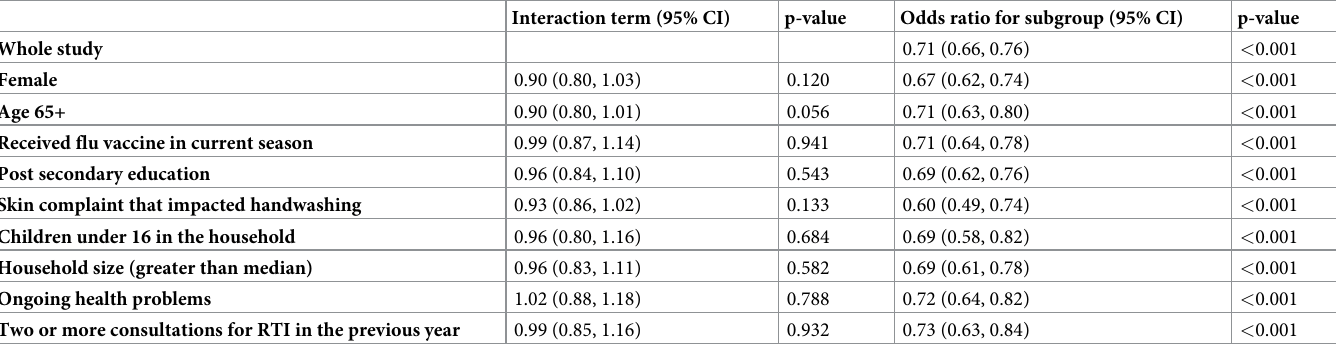
Table 3. Subgroup effects for PRIMIT primary